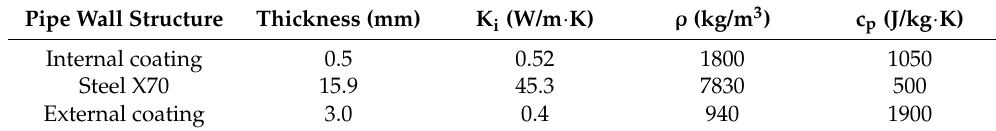
Table 2. Properties of pipe wall.